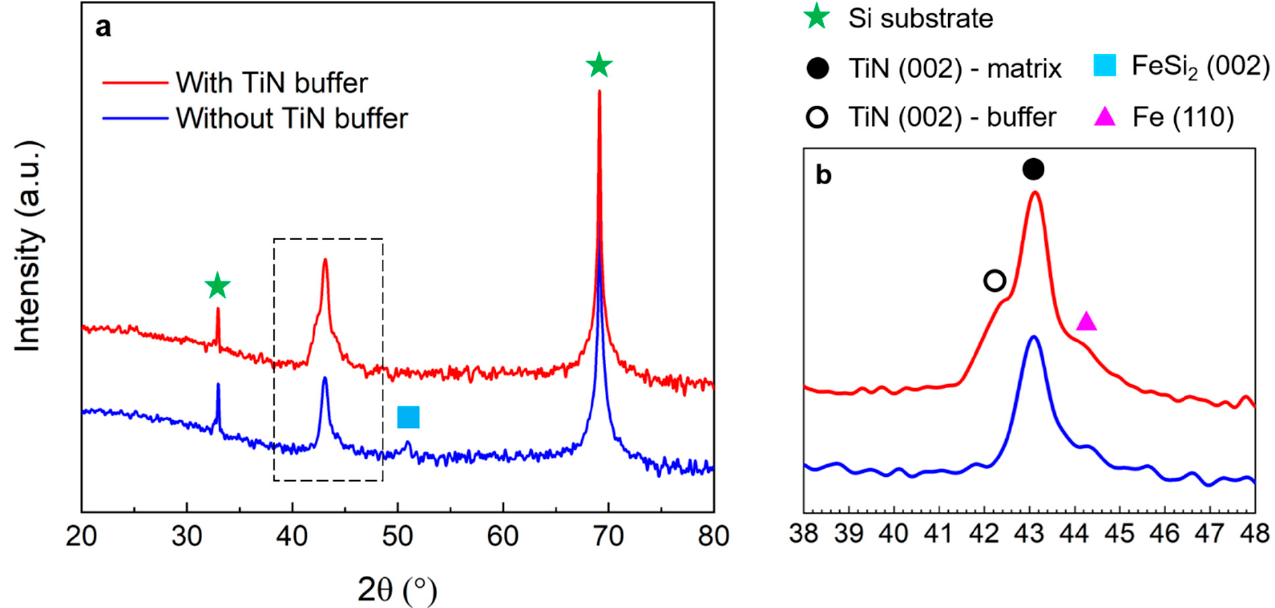
Figure 2. ( a ) X-ray diffraction θ –2 θ patterns of the TiN–Fe thin films deposited on Si (001) substrates with and without a TiN buffer layer and ( b ) the local measurement centered around 43 ◦ to distinguish the TiN (002) and Fe (110) peaks.